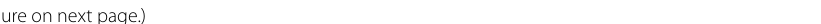
figure on next Fig. 4 The interrelationship between surface residue cover on soils with varying soil moisture on blue and red spectral reflectance wavelength bands (top), Normalized Difference Vegetation Index (NDVI) and Normalized Difference Water Index (NDWI) (bottom). The data is from a study conducted at Aurora and Lennox site (South Dakota, USA). The soil moisture content approximately 8% for dry soil, and 20% for wet soil respectively. The 95% confidence interval for the regression equation is shown (Source: de Paul Obade